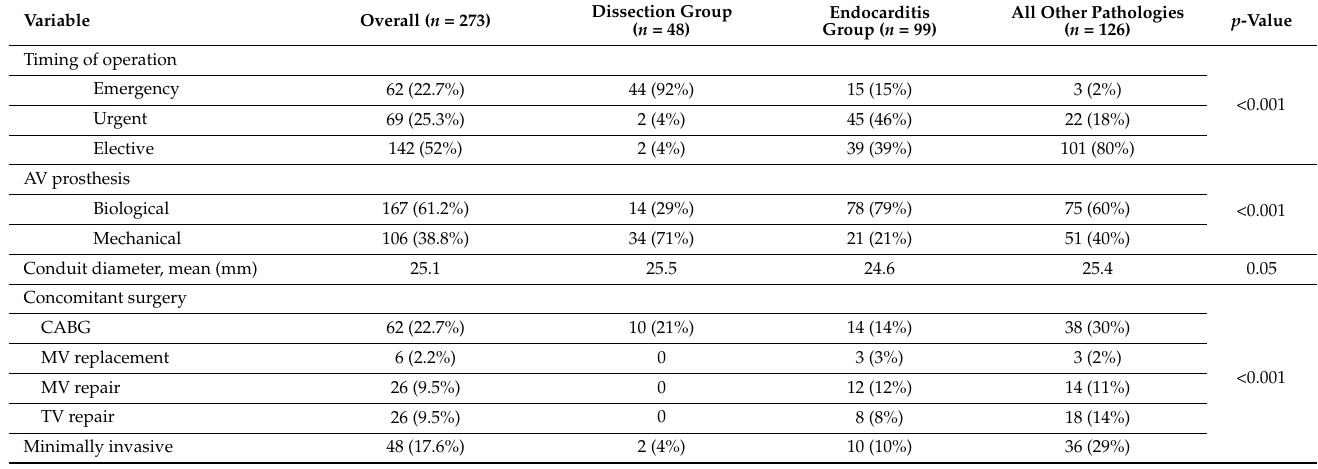
Table 2. Operative